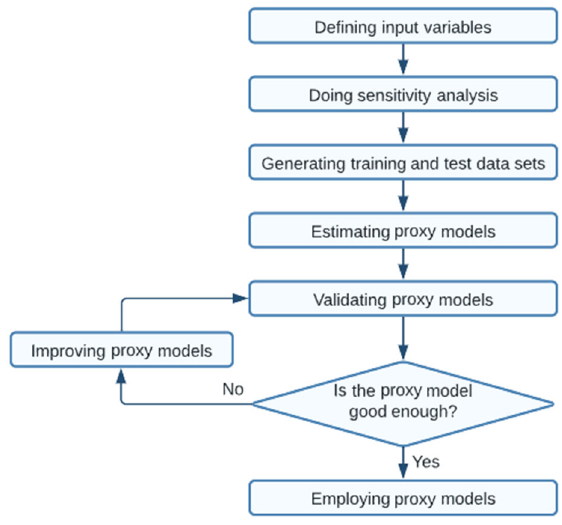
Figure 9. The workflow for proxy model development.